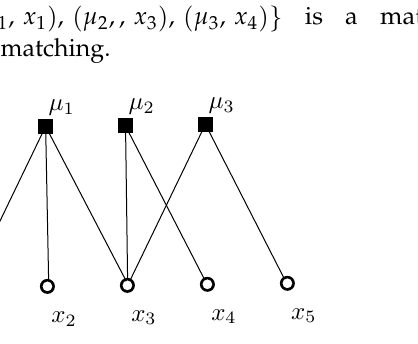
Figure 2. An example for Definition 2, where it contains two types of sample point sets { µ 1 , µ 2 , µ 3 } and { x 1 , x 2 , x 3 , x 4 }